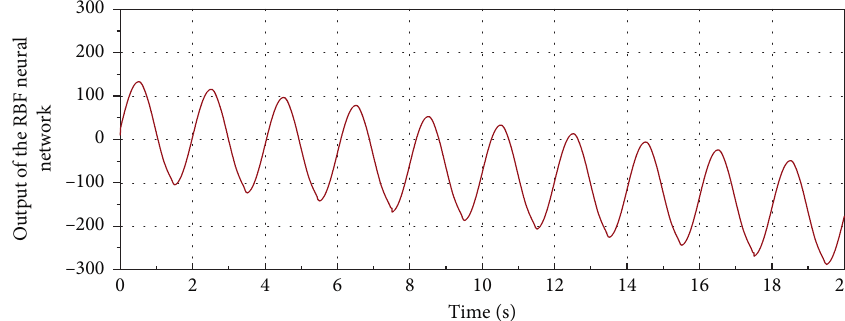
Figure 8: Output of the RBF neural network.